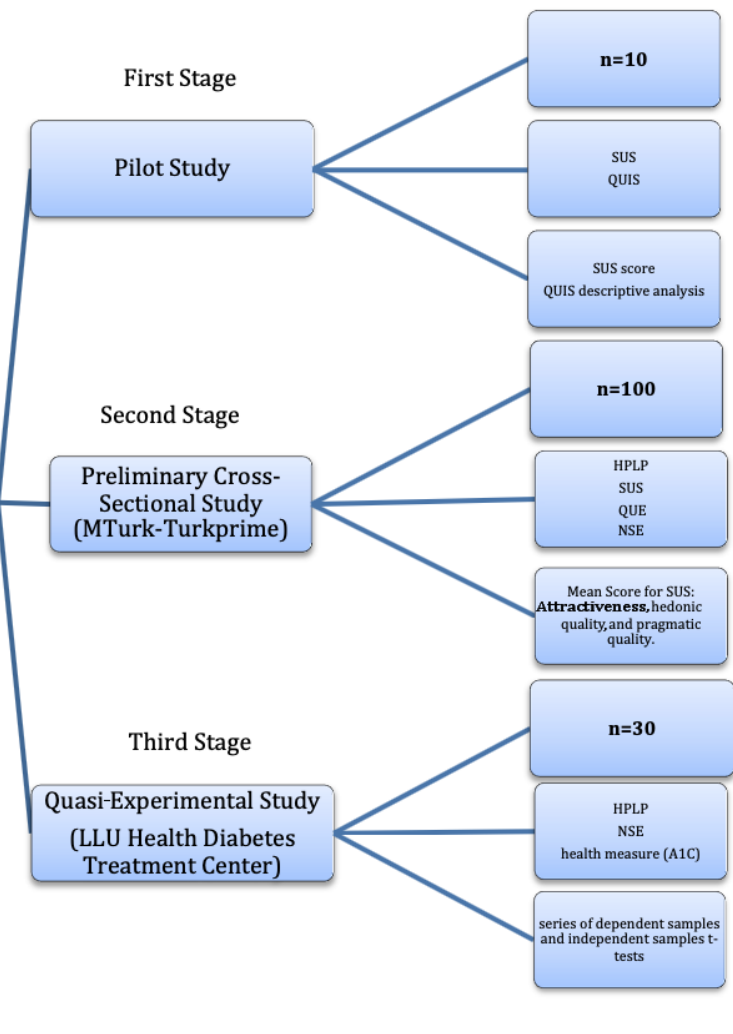
Figure 7. The evaluation plan (subjects, measures, and